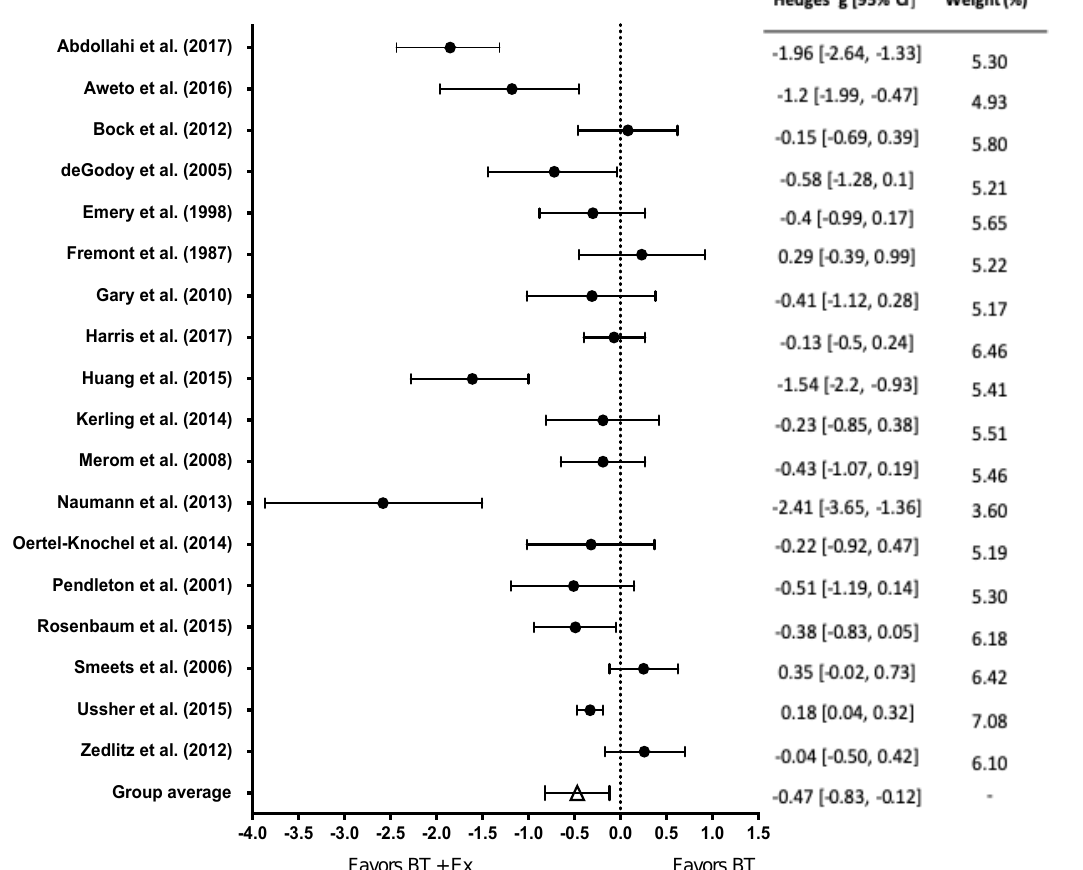
Figure 2. Overall effect of BT+Ex on depression. Test for overall effect g = −0.47, p = 0.005; BT+Ex = Figure 2. Overall e ff ect of BT + Ex on depression. Test for overall e ff ect g = − 0.47, p = 0.005; Behavioral Therapy + Exercise, BT = Behavioral Therapy only. BT + Ex = Behavioral Therapy + Exercise, BT = Behavioral Therapy